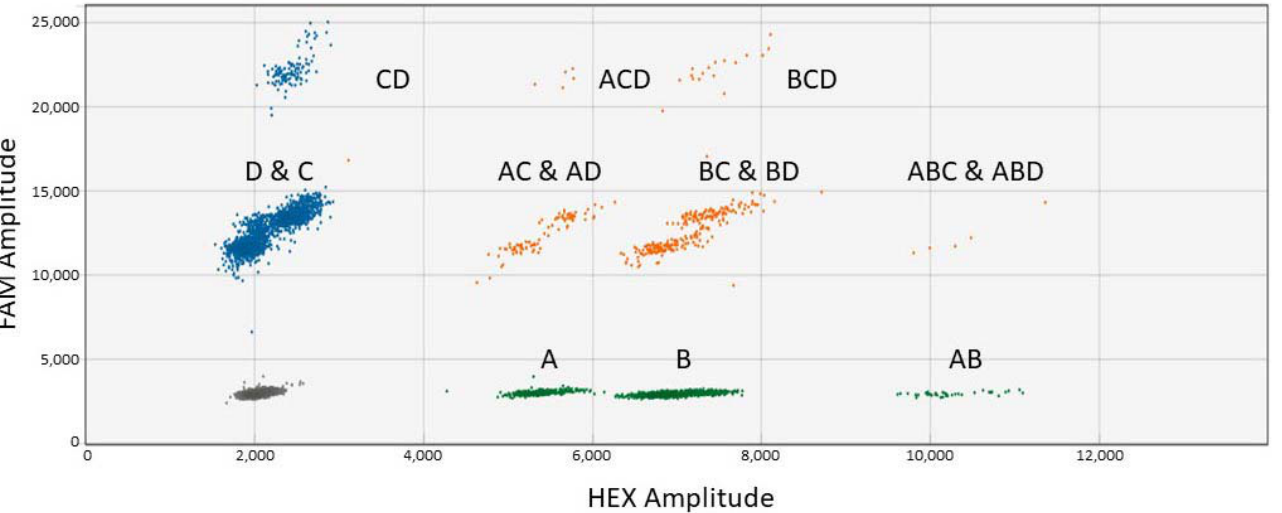
Figure 1. Droplet clusters generated for the non-optimized soybean tetraplex ddPCR assay (two- dimensional view). A = DP305423 event (HEX); B = DAS81419 event (HEX); C = MON89788 event (FAM); and D = A2704 event (FAM). The dark cluster represents negative droplets. Table 2. Experimental results for duplex ddPCR assays for GM canola and soybean events. Crop Duplex